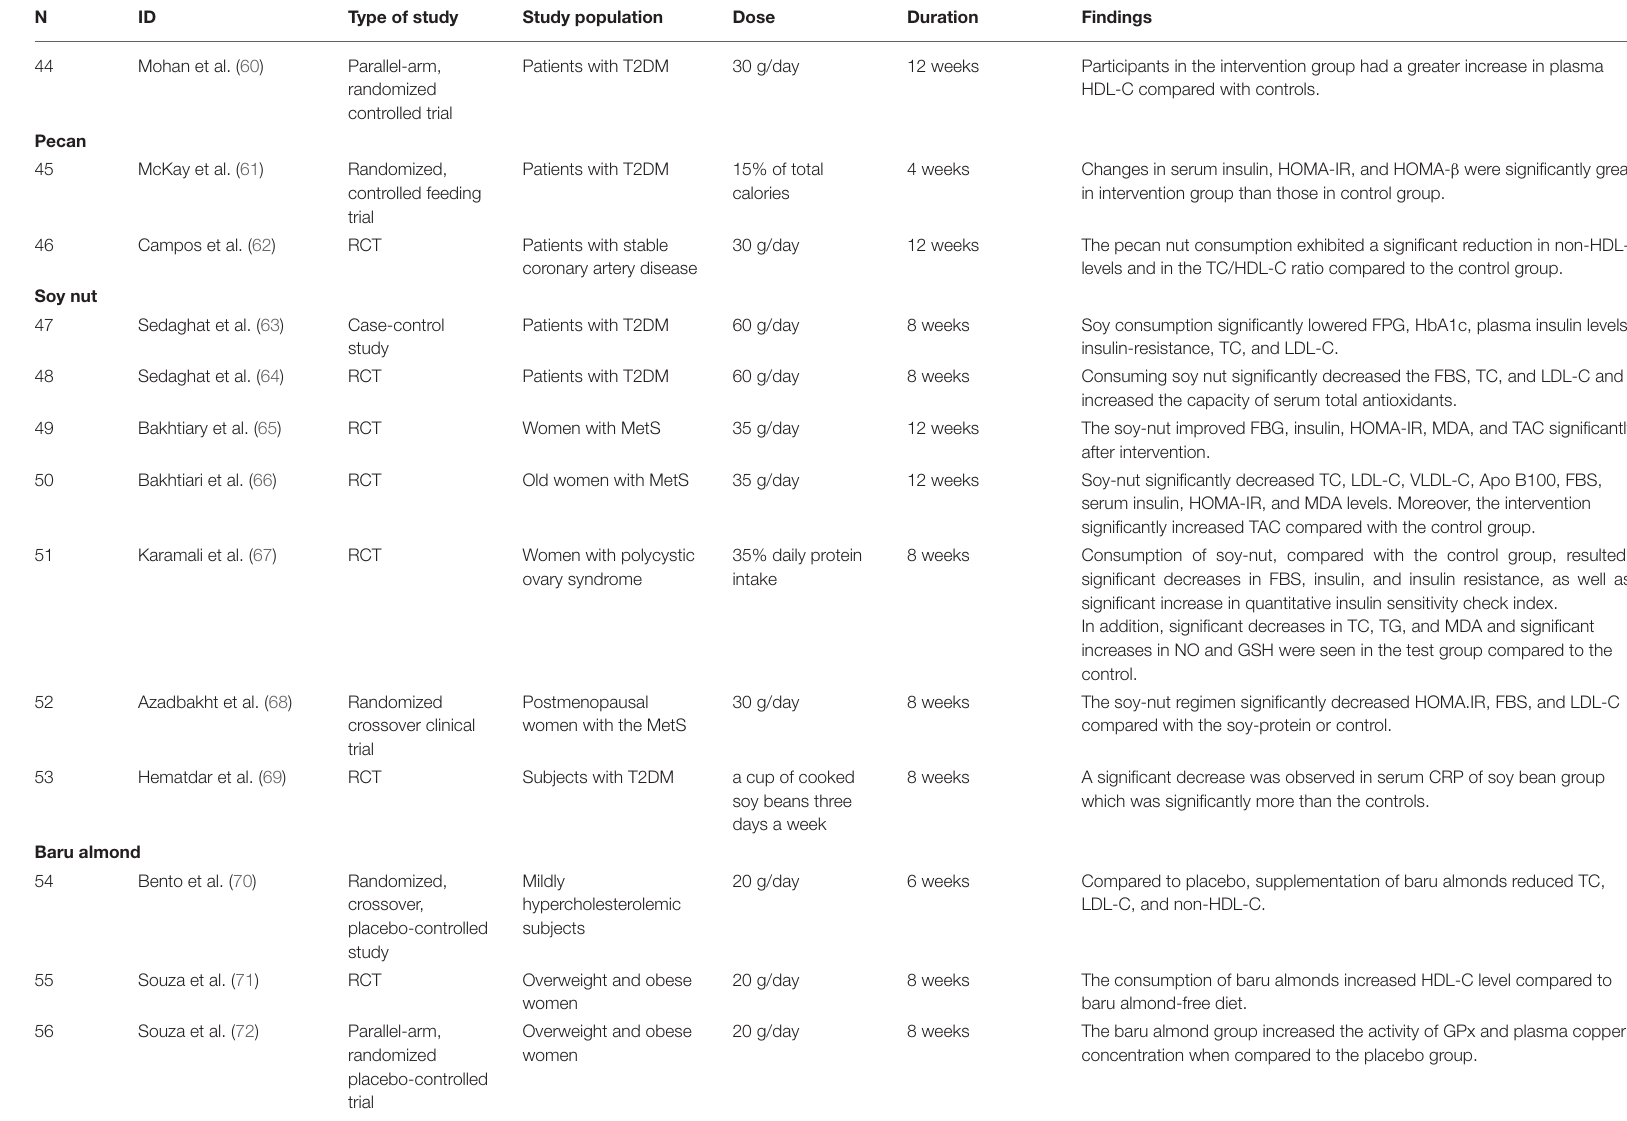
FBS, fasting blood sugar; HOMA.IR, homeostatic model assessment for insulin resistance; HOMA- β , homeostasis model assessment of β -cell function; HbA1c, glycated hemoglobin; TC, total cholesterol; TG, triglyceride; LDL-C, low-density lipoprotein cholesterol; HDL-C, high-density lipoprotein cholesterol; IL, interleukin; hs-CRP, high-sensitivity C-reactive protein; TNF- α , tumor necrosis factor alpha; MDA, Malondialdehyde; TAC, total antioxidan capacity; SOD, superoxidedismutase;GPX,glutathioneperoxidase;TBARS,thiobarbituricacidreactivesubstances;CAT,catalase;ACE,angiotensin-convertingenzyme;PPAR- γ ,peroxisome-proliferatoractivatorreceptor γ ;FPG,form-amido-pyrimidine glycosylase; NO, nitric oxide; Apo B, apolipoprotein B; T2DM, type 2 diabetes mellitus; MetS, metabolic